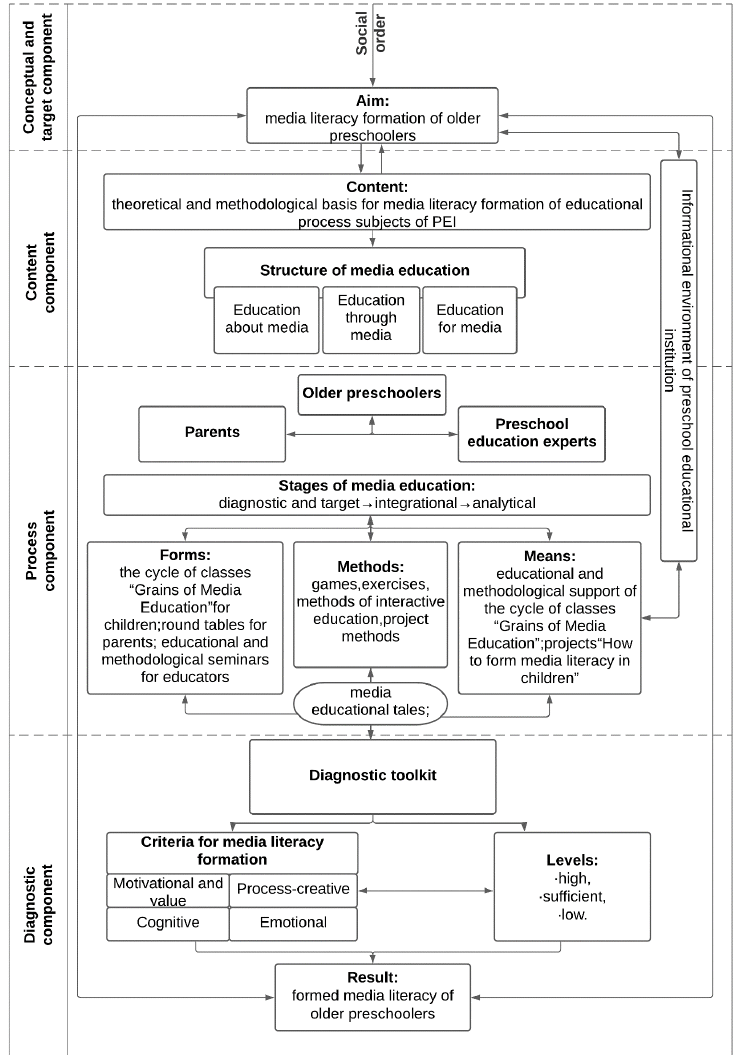
Figure 62: Presentation of paper